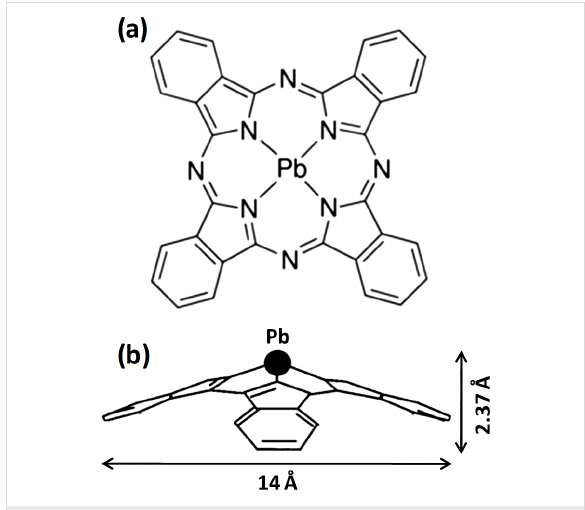
Figure 1: Chemical structure of lead phthalocyanine. (a) Top view and (b) side view of a Pb(II)Pc molecule.